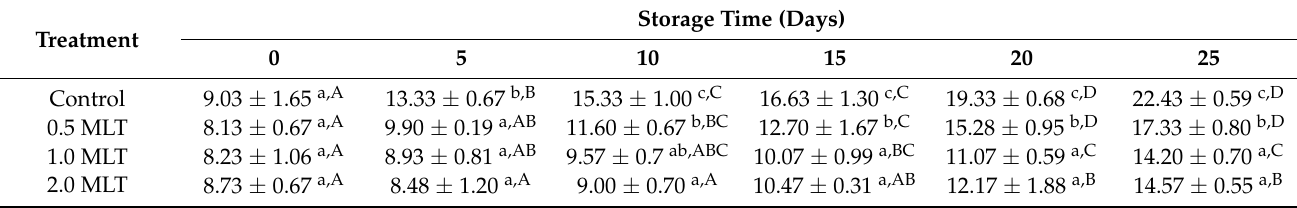
Table 6. Effect of melatonin treatment on hydrogen peroxide content (mg/100 g fresh weight) of green asparagus during 25 days of storage at 4 ◦ C and 90% relative